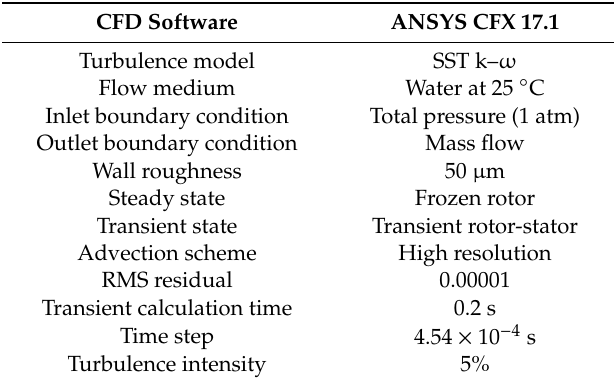
Figure 9. Analysis of the sensitivity of time steps in the numerical simulation. Table 3. The numerical setup.